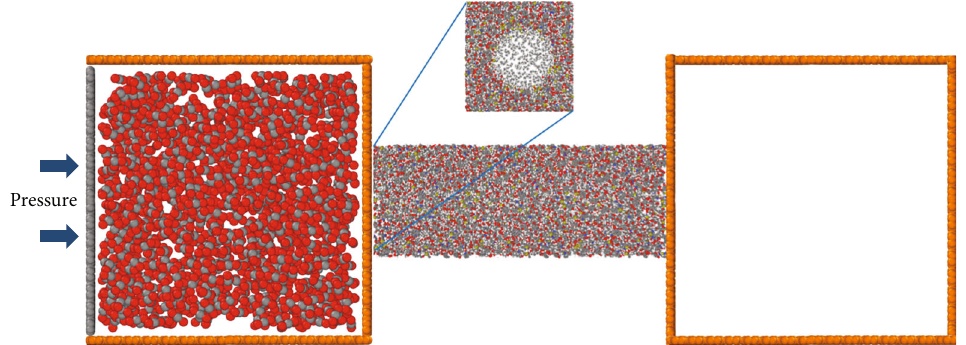
Figure 9: Molecular model of CH injection pressure in box. The injection gas is either CO